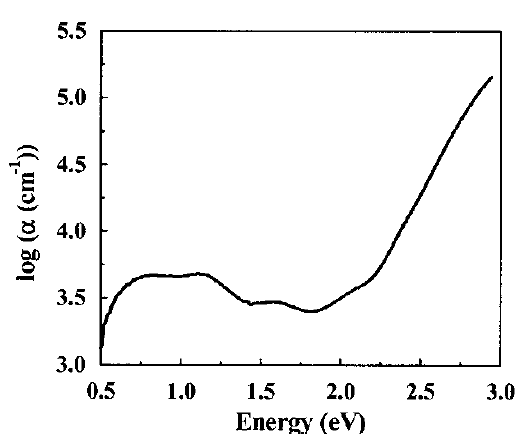
FIGURE 6 Absorption coefficient versus photon energy for V 2 O 5 thin films spin-coated at 1800rpm.